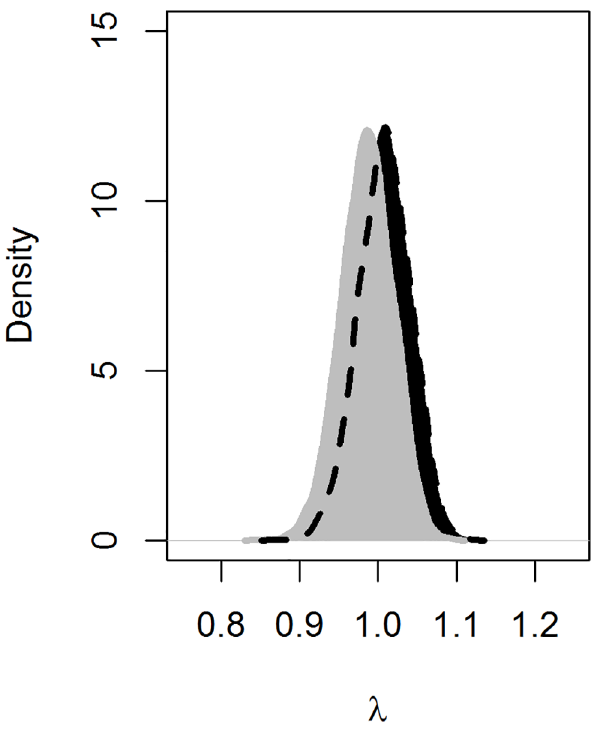
Fig 5. Estimates of population growth rates with and without CWD. Population growth rates using survival, fertility, and infection estimates aggregated among wintering subpopulations with (gray) and without (black) CWD. The amount that the gray polygon is shifted to the left towards zero shows the direct contribution of CWD to lowering growth rate under the conditions